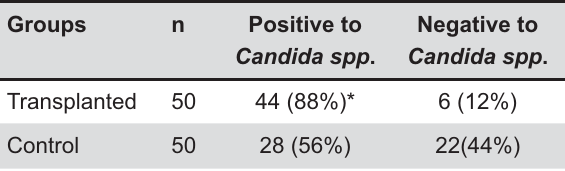
Table 1- Number and percentage of individuals positive to Candida spp . in the oral cavity